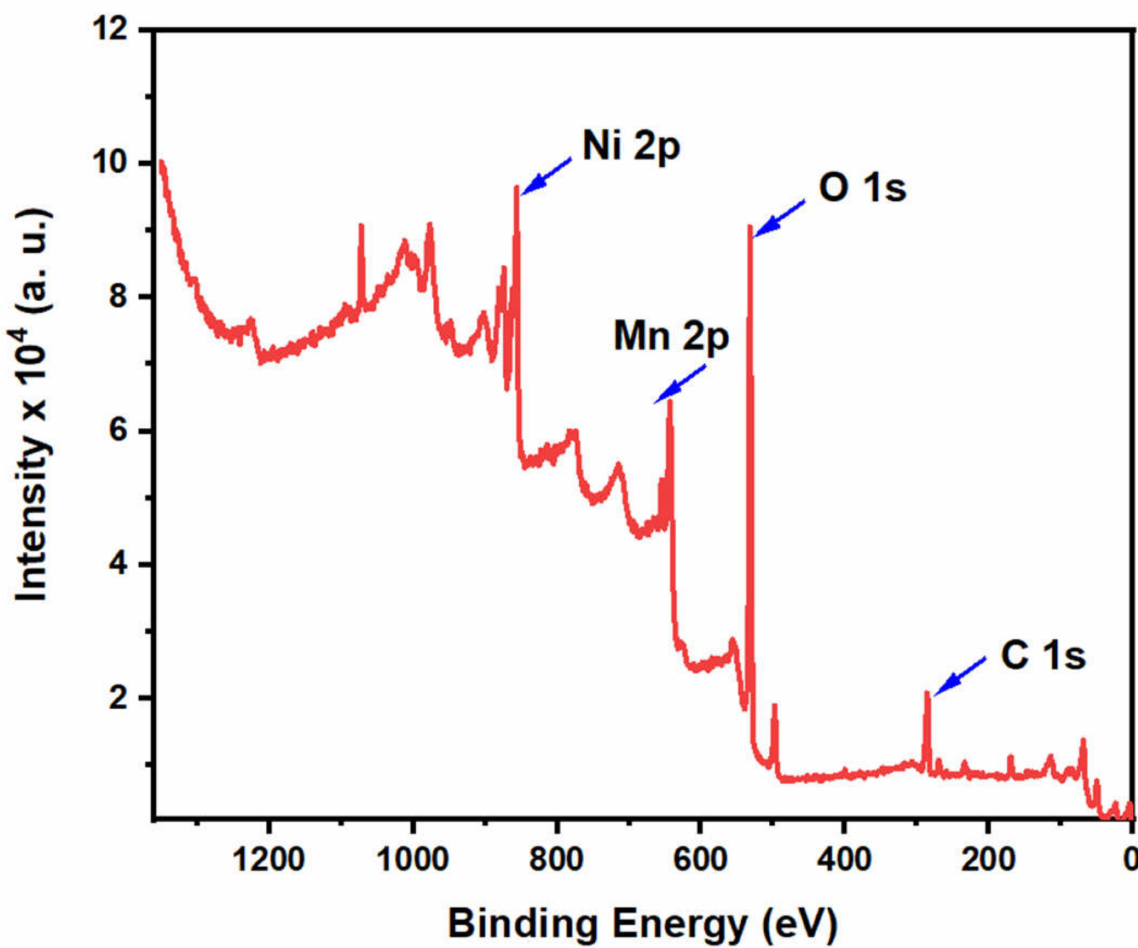
Figure 5. X-ray photoelectron survey scanspectrum forthe synthesized Ni(OH) 2 @Mn 3 O 4 nanocomposites.